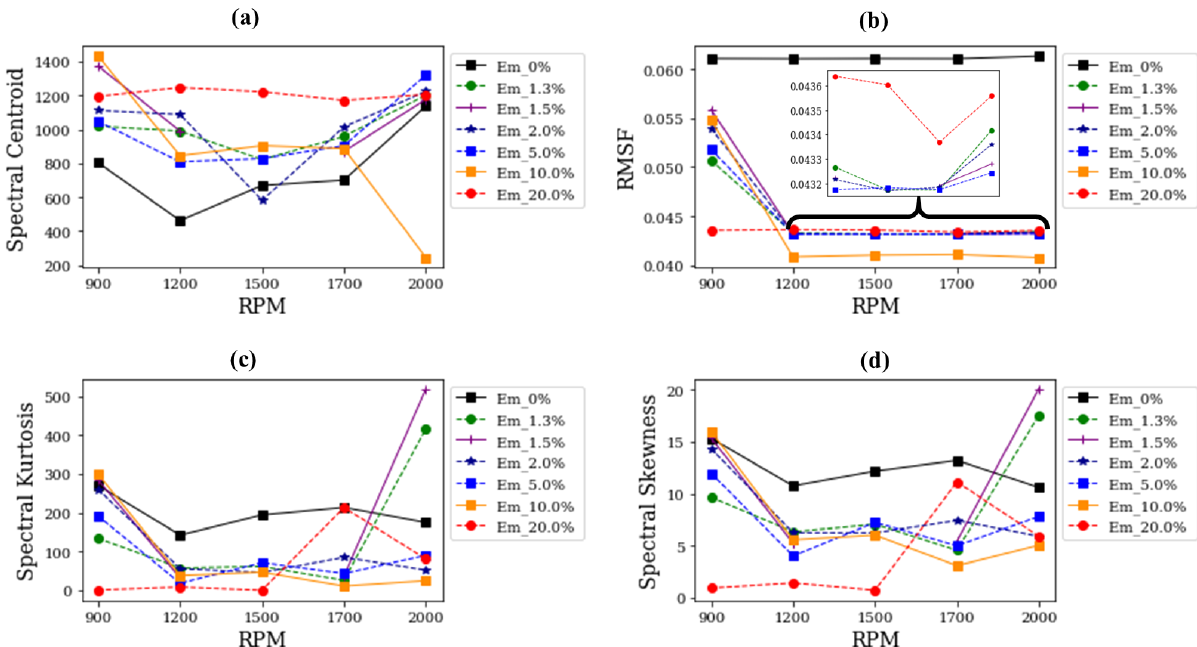
Figure 5. Spectral parameters of CR pressure differentials for different emulsion compositions ( a ) spectral Centroid, ( b ) RMSF, ( c ) Spectral kurtosis, and ( d ) Spectral skewness.